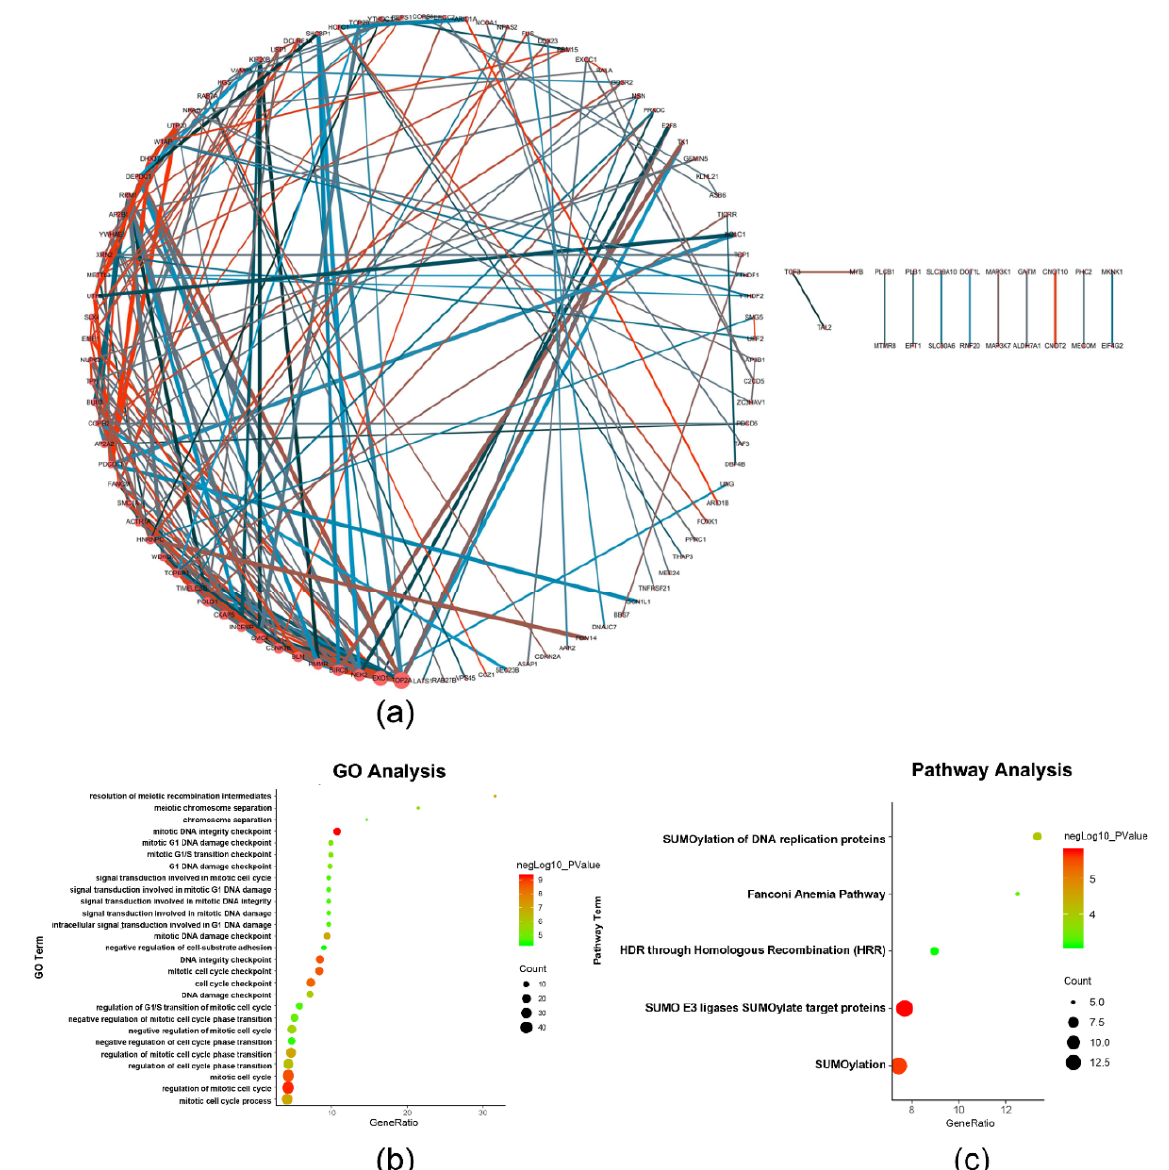
Figure 2. Protein–protein interaction network and enriched analysis of the survival-related m6A RNA methylation-related genes. ( a ) The protein–protein interaction network of the survival-related m6A RNA methylation-related genes was constructed by Cytoscape. Nodes were represented as genes and the size of nodes represents degree of the nodes. Edges were represented as interactions and the color and width of edges represent the value of combined score and co-expression. ( b ) Each biological function term is represented by a node, its color represents p -value, and its size represents the number of genes. ( c ) Each pathway term is represented by a node, its color represents p -value, and its size represents the number of genes.